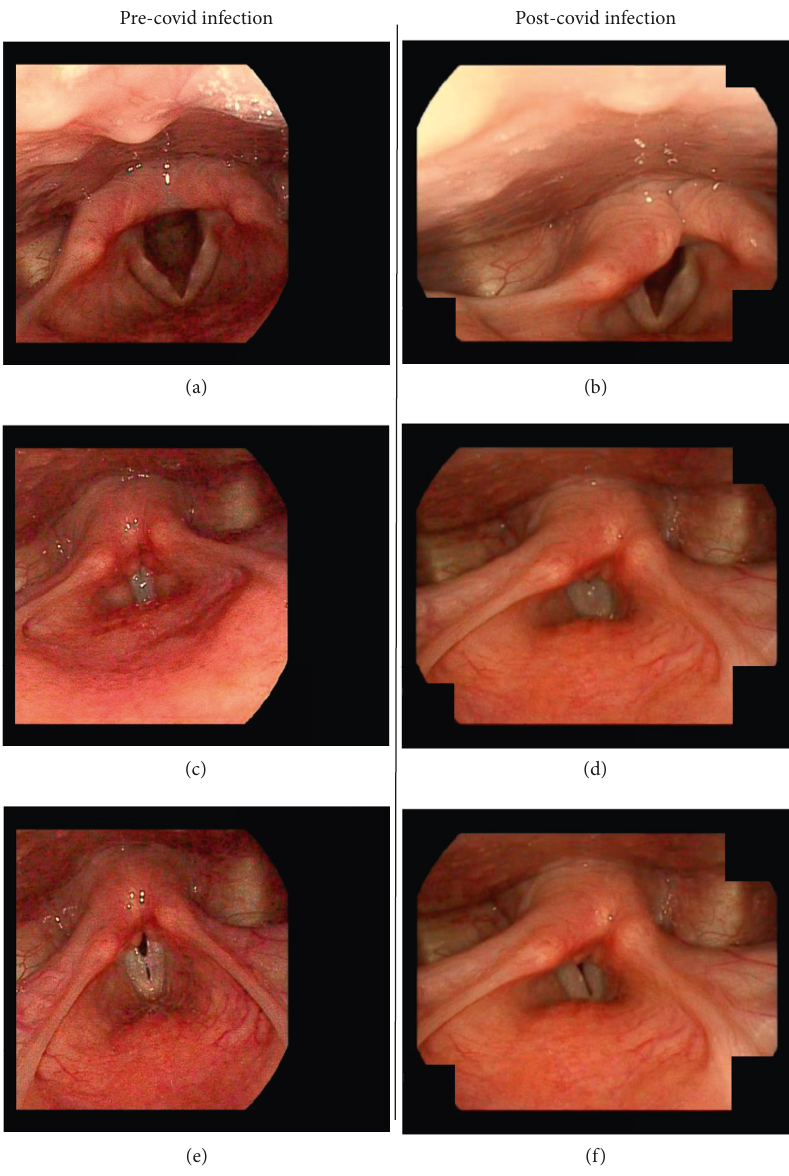
Figure 1: Videostroboscopy. A comparison of images taken 7 months before the SARS-CoV-2 infection (a, c, e) with images taken 2 months after the SARS-CoV-2 infection (b, d, f). Images (a, b) show abduction, images (c, d) show adduction, and images (e, f ) show relaxed phonation. Previous videostroboscopy was available for comparison due to prior evaluation of the patient’s muscle tension dysphonia and vocal cord